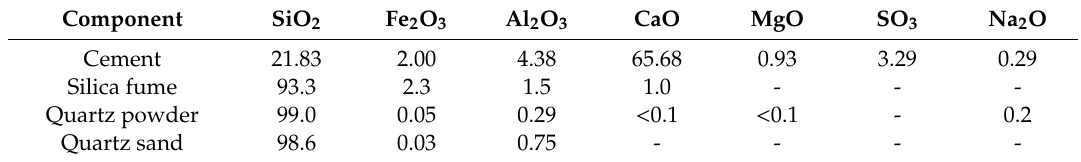
Table 1. Chemical composition of reactive powder concrete (RPC) components (wt.%).